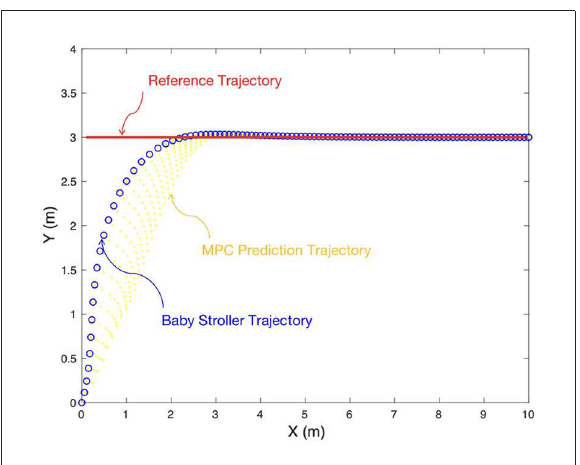
FIGURE8 Experimental results of tracking the straight line